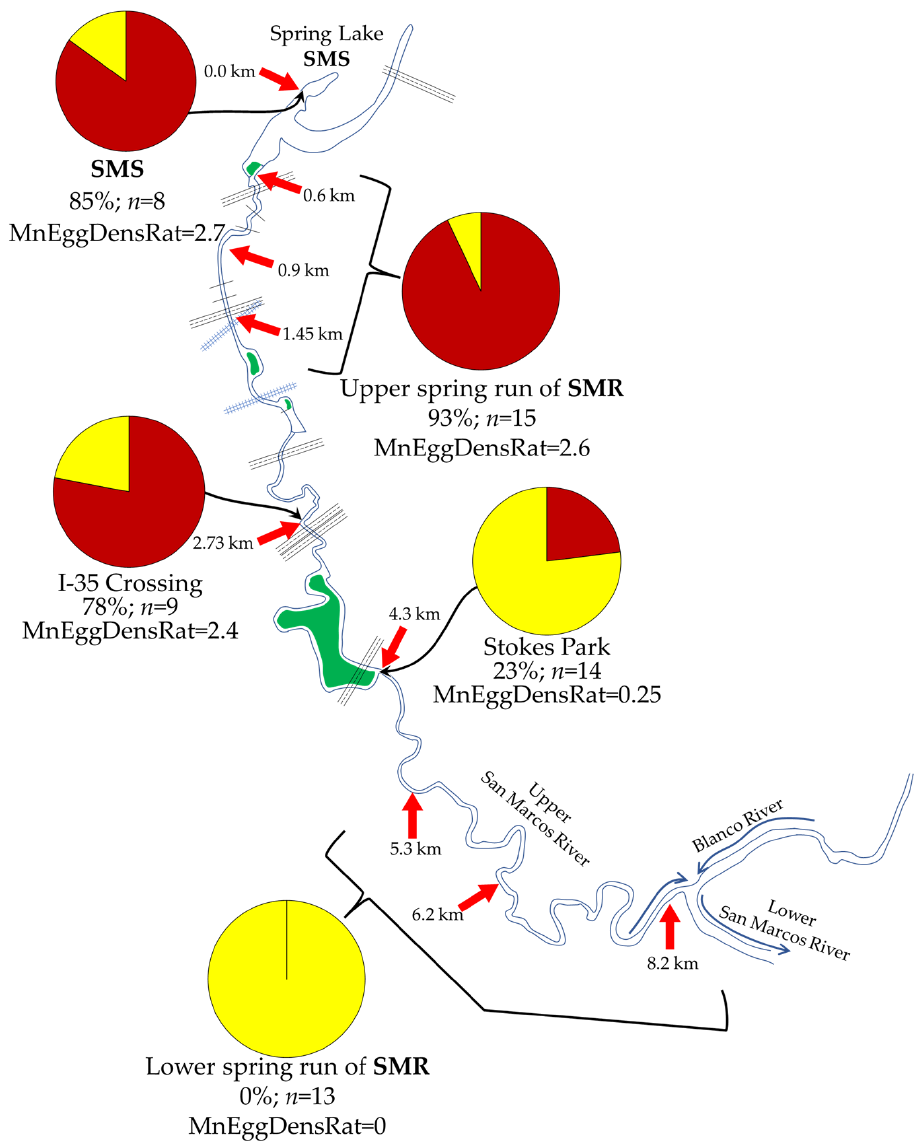
Figure 3. Map of San Marcos River, Hays County, TX, showing decline in Huffmanela abundance at progressively more downstream stations as measured by prevalence and mean egg‑density ratings in wild‑caught fish (red pie slices = %fish positive; yellow slices = %fish negative for H. huffmani ). Distances are approximate thalweg kilometers down-stream from headsprings (29.894038, − 97.930154) based on a path traced in Google Earth Pro (map data ©12/21/2018 Google). n refers to number of fish sampled from each location.